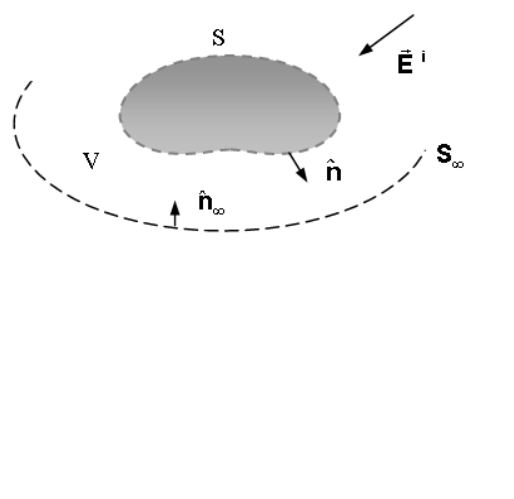
Figure 2a. Geometry of the scattering problem. Figure 2b. Scattering by a raindrop: Electric